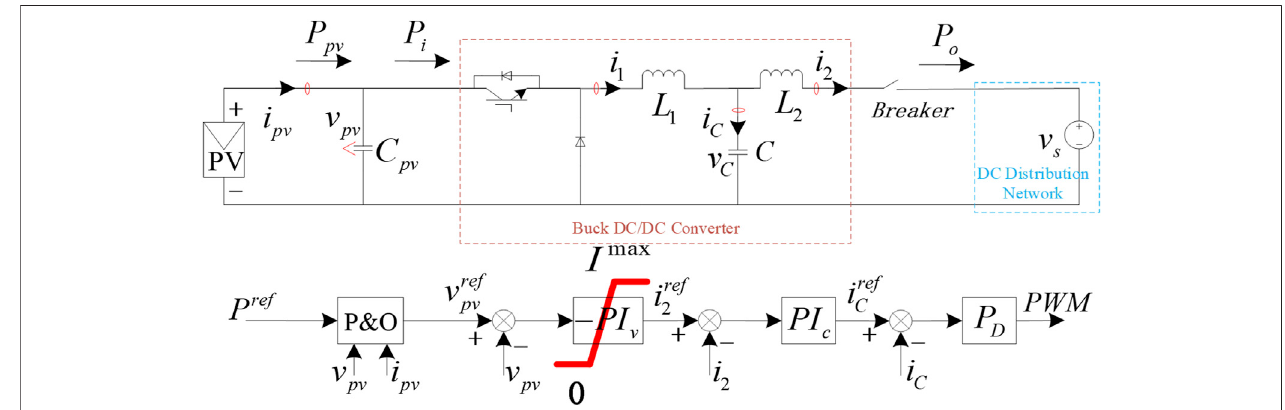
FIGURE 1 | Topology and control of a PV generator connected to the DC distribution